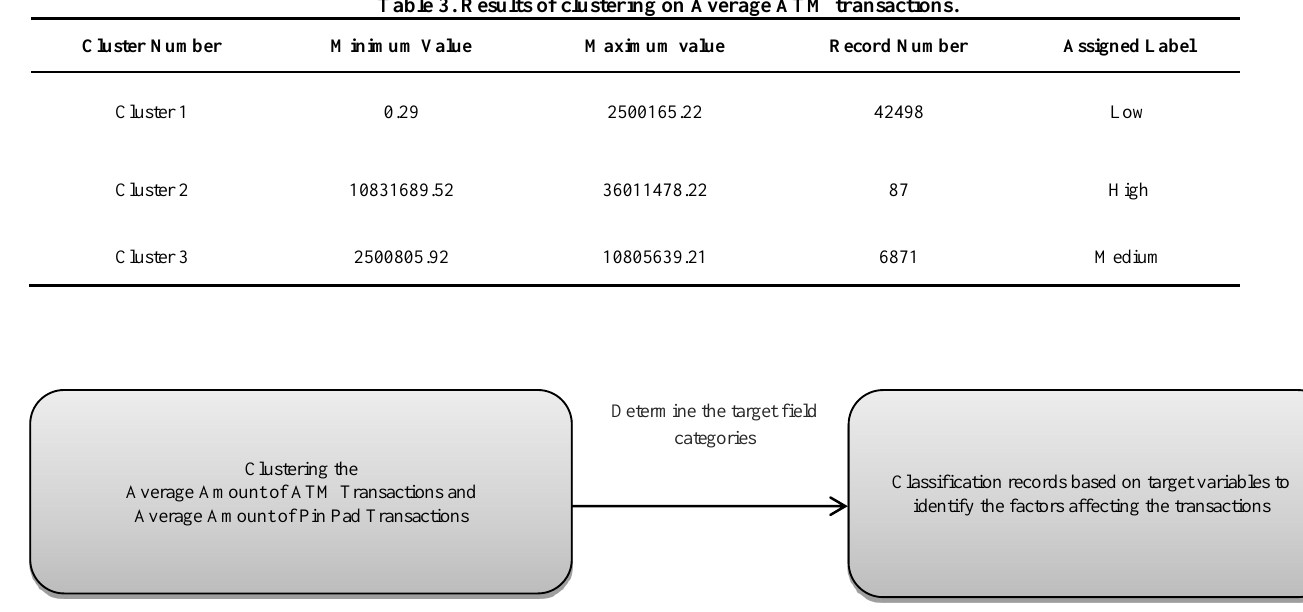
Figure 3. Determination of target field